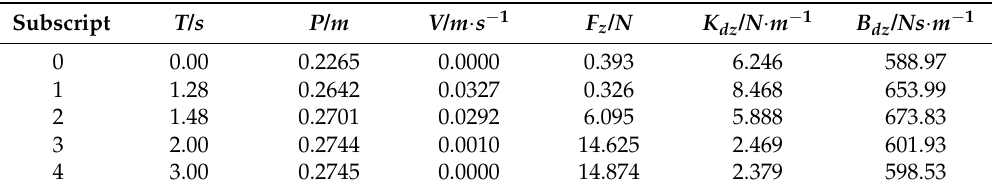
Table 1. Key states of the four phases during the 20th